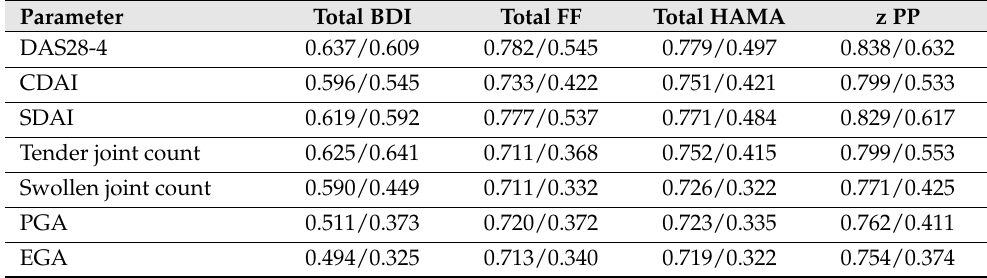
Table 6. Intercorrelation matrix of psychopathology rating scale scores and the indices of clinical severity of rheumatoid